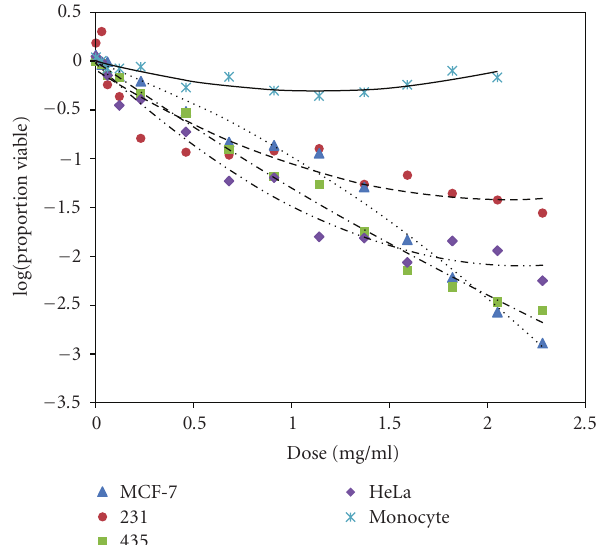
Figure 2: Comparison of the dose-response curves for extracts of Atriplex confertifolia against three human breast cancer cell lines; 435, 231, MCF-7, HeLa, and normal human lymphocyte